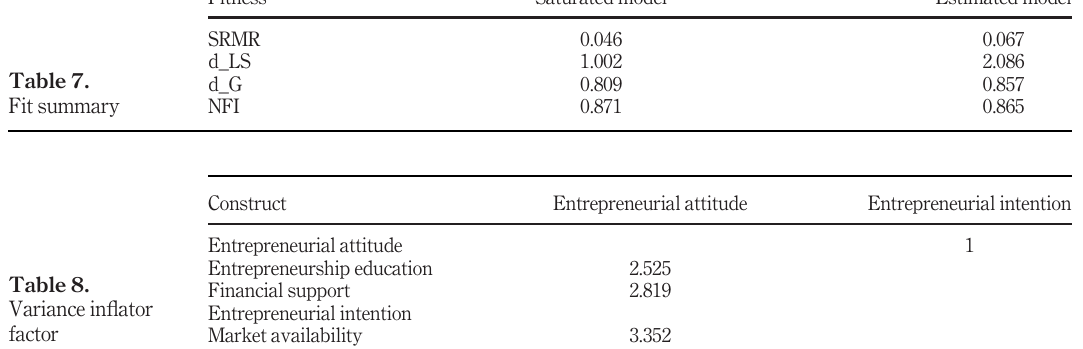
Table 6. Heterotrait –